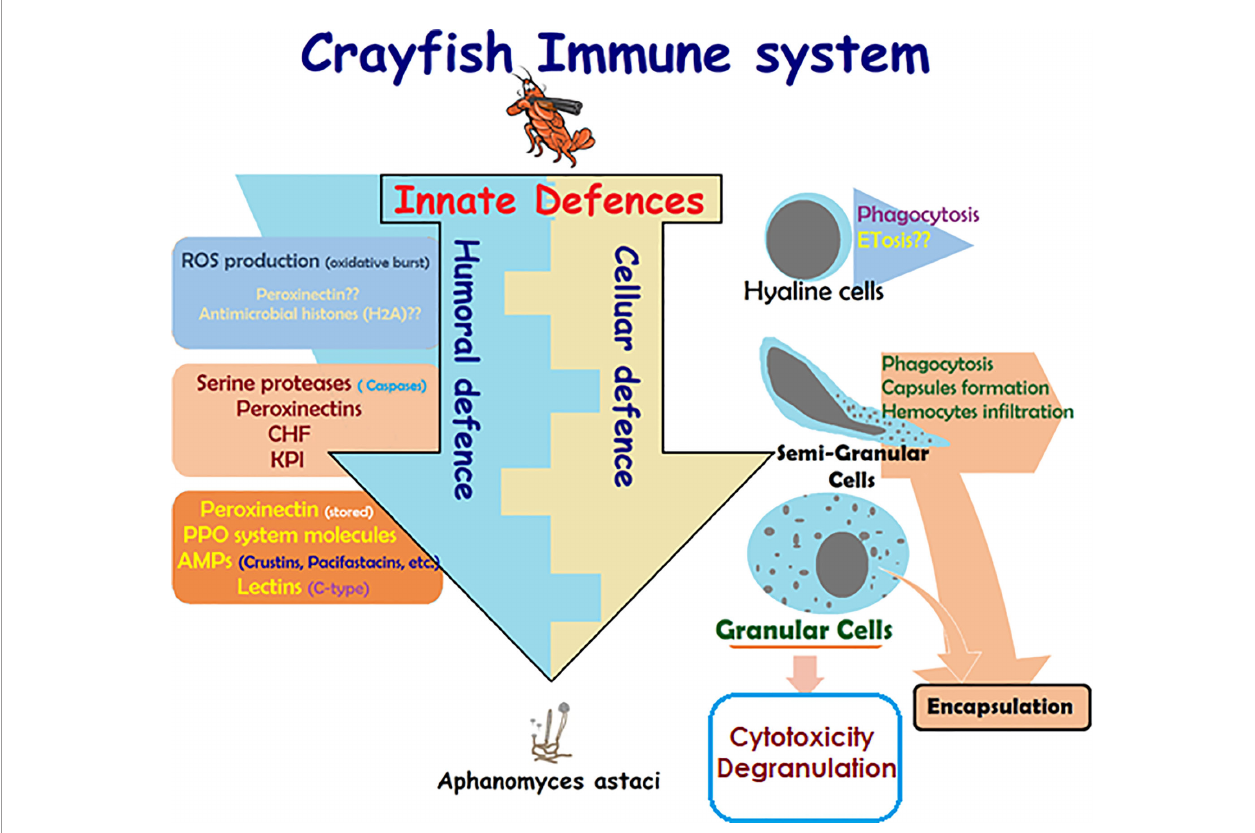
FIGURE 1 | Schematic presentation of cray fi sh immune response. Presentation of the main constituents of cray fi sh immune response alongside the cooperative action of the cellular-mediated and humoral-mediated responses and their corresponding factors (4, 5, 14, 17, 18, 26, 28 – 30, 42 –